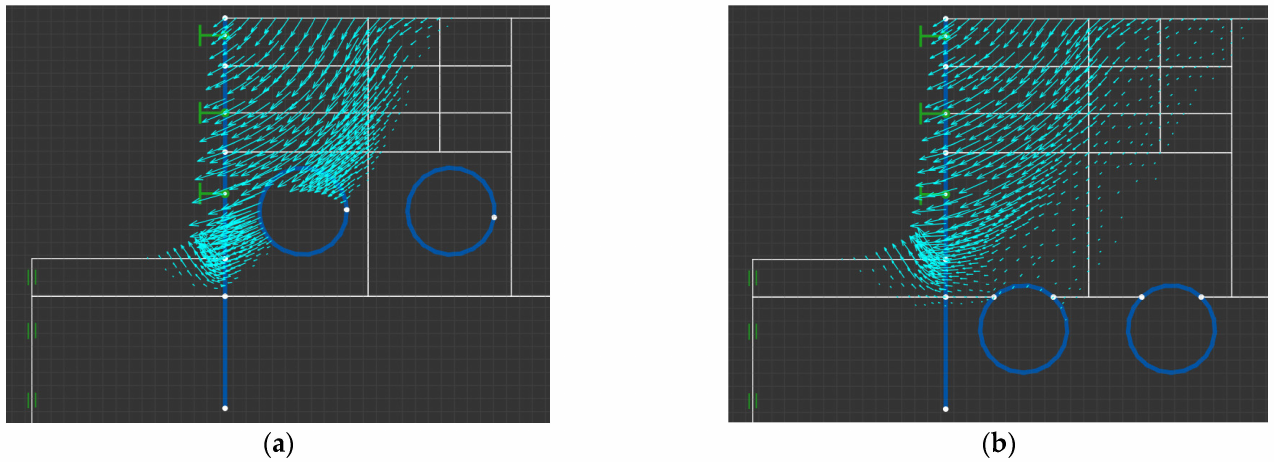
Figure 23. Incremental displacement vector under different cover depth C of the twin shield tunnels in stage (4): ( a ) C = 0.5 H and ( b ) C = 1.0